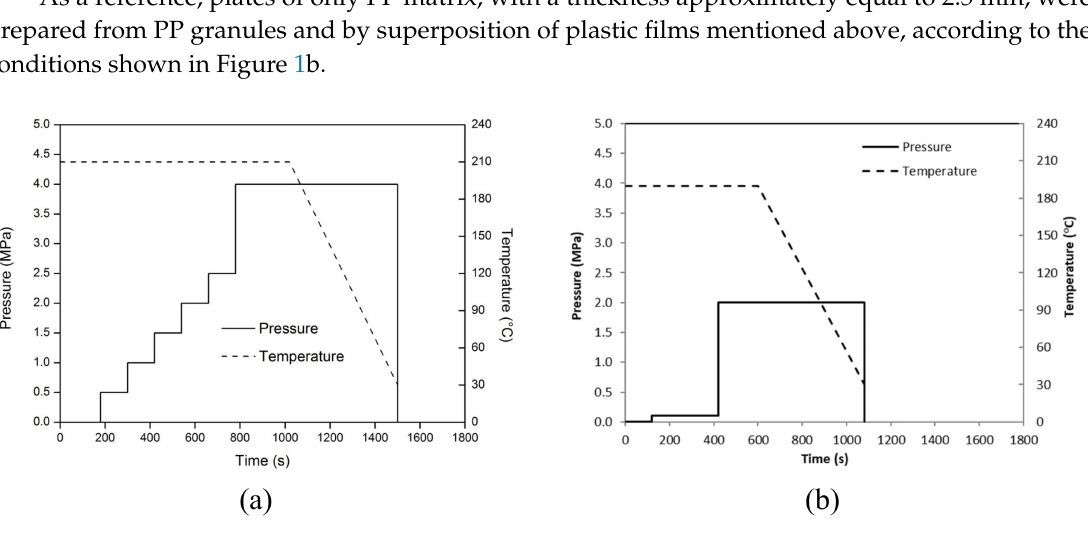
Figure 1. Hot-pressing conditions for ( a ) composite and reference ( b )